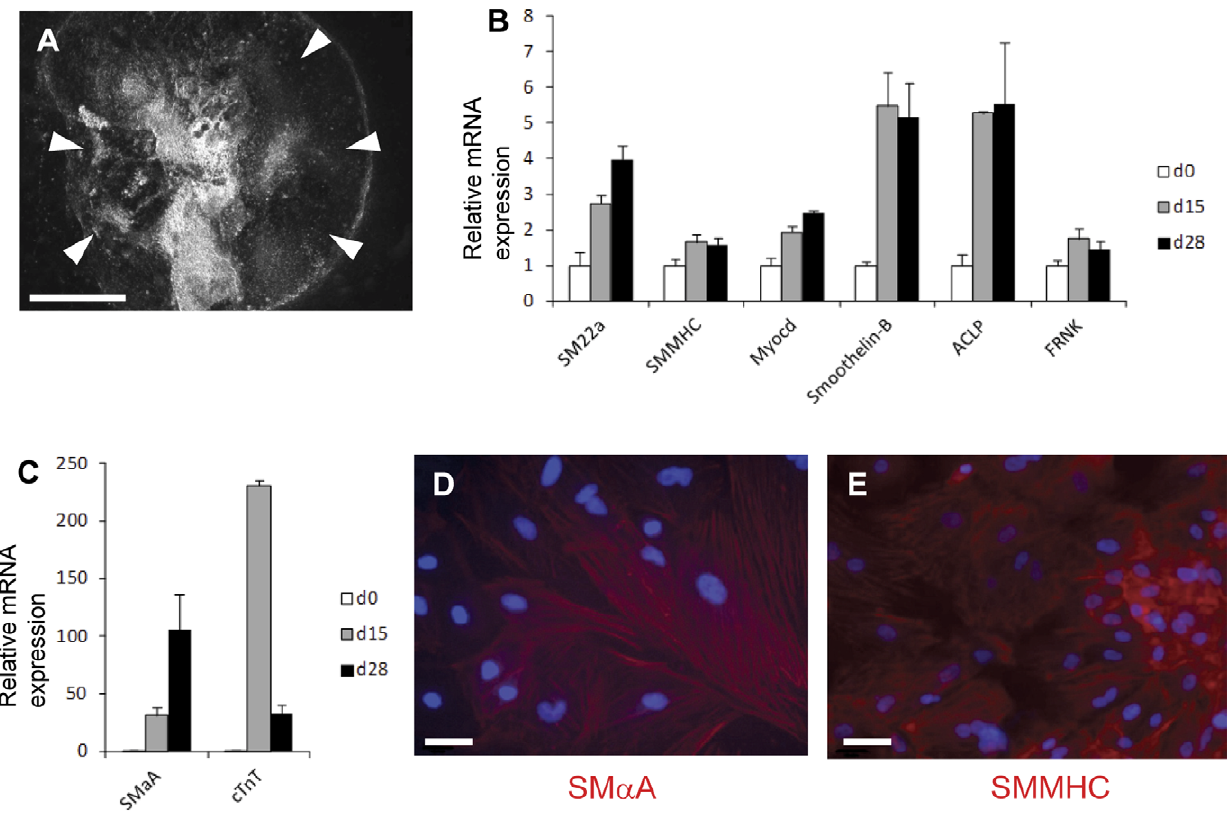
Figure 1. Development of SMCs in human embryoid bodies. (A) Low power dark field image of day 28 human embryoid body grown in 20% FBS showing outgrowth of cells (white arrowheads) from the central embryoid body mass. (B and C) Expression of SMC specific genes in embryoid bodies by real time RT-PCR at days 0, 15 and 28 is normalised by three housekeeping genes (GAPDH, UBC, 18S) and then presented relative to undifferentiated human ESCs. RT-PCR data represent means from three independent experiments. Bars represent s.e.m. Cells that stain for SM a A (D) and SMMHC (E) clearly seen at day 28 within embryoid bodies by immunofluorescence. Nuclei counterstained (blue) with DAPI. Bar in A=1000 m m, bars in D and E=20 m